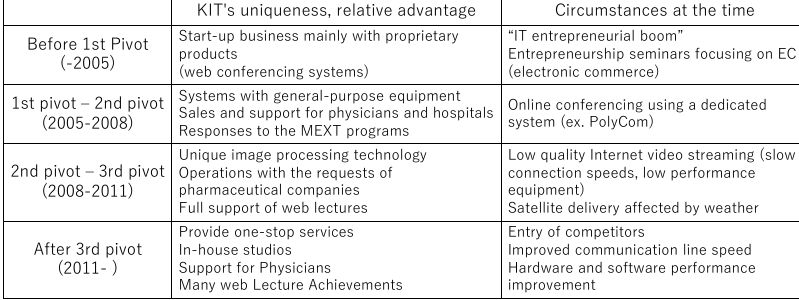
Table 1. Change of KIT’s competitive advantage